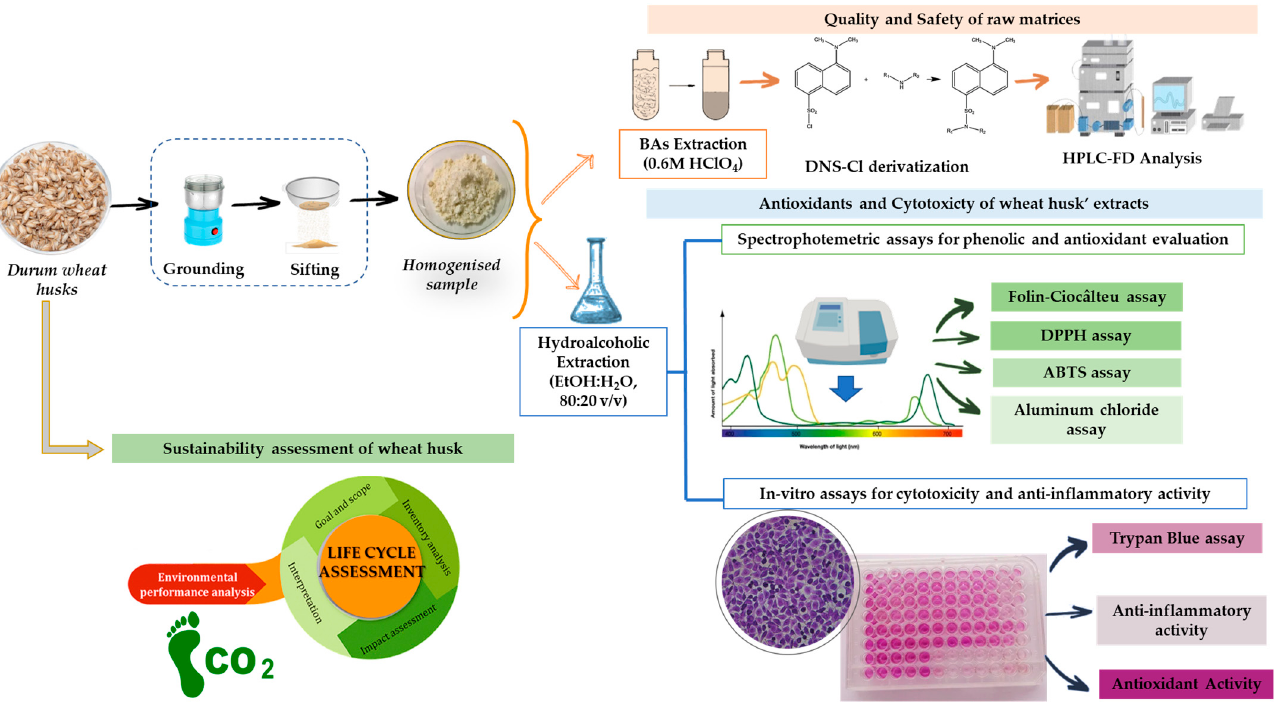
Figure 2. Multimethodological approach for the recovery of bioactive compounds from the wheat husk.